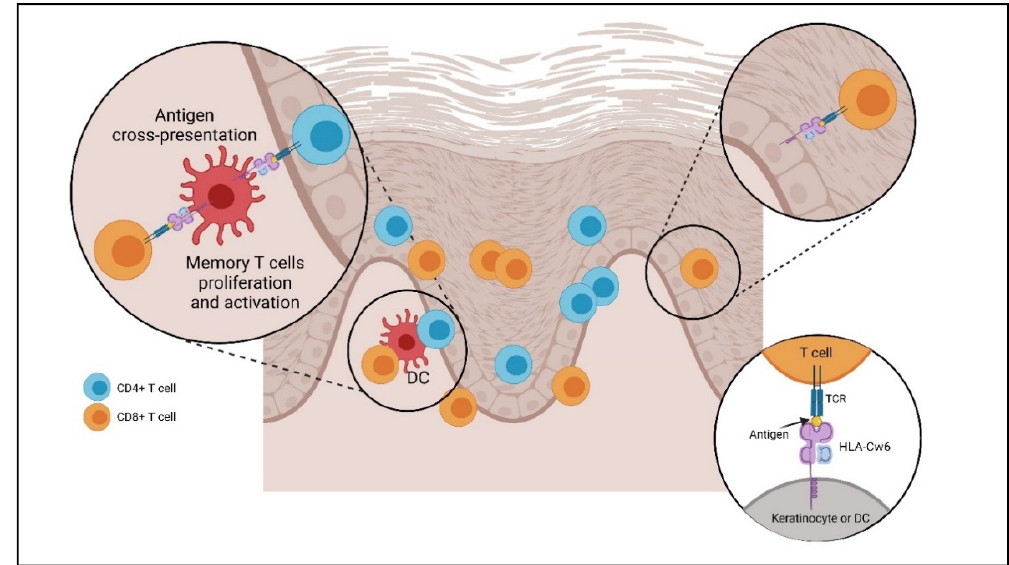
Figure 2. Role of HLA-Cw6 in psoriasis pathogenesis. Created with BioRender.com (accessed on 18 February 2022).